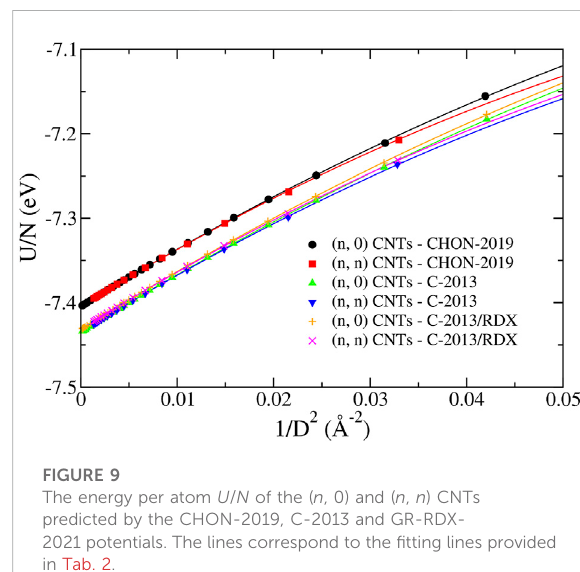
The energy per atom U / N of the ( n , 0) and ( n , n ) CNTs predicted by the CHON-2019, C-2013 and GR-RDX- 2021 potentials. The lines correspond to the fi tting lines provided in Tab. 2.